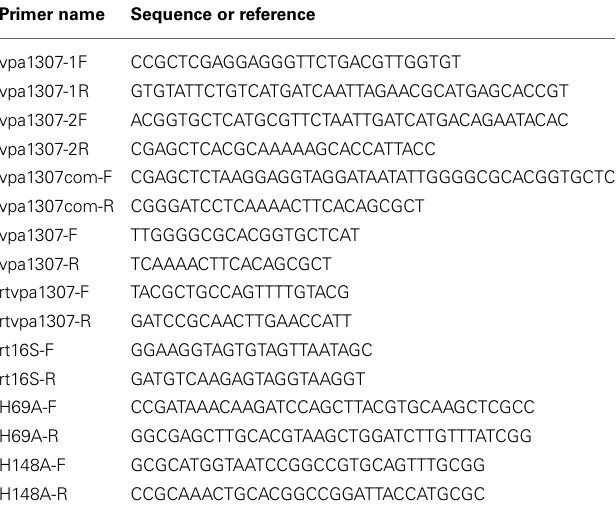
Table 2 | Primers used in this